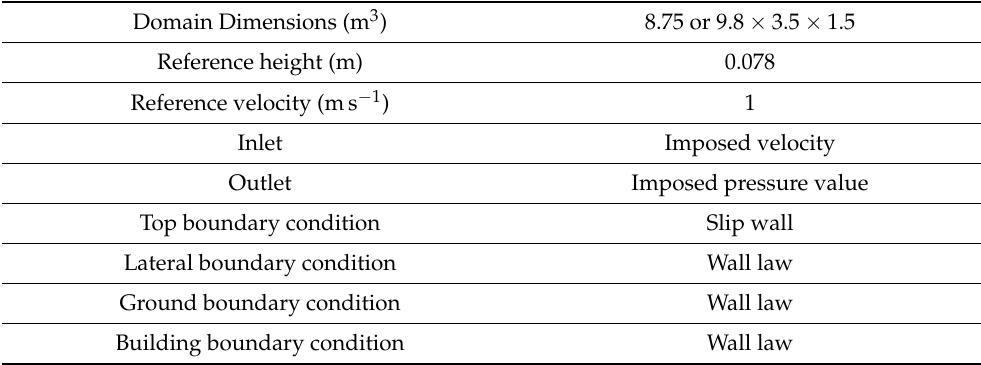
Table 6. Model settings for the urban area dispersion case.